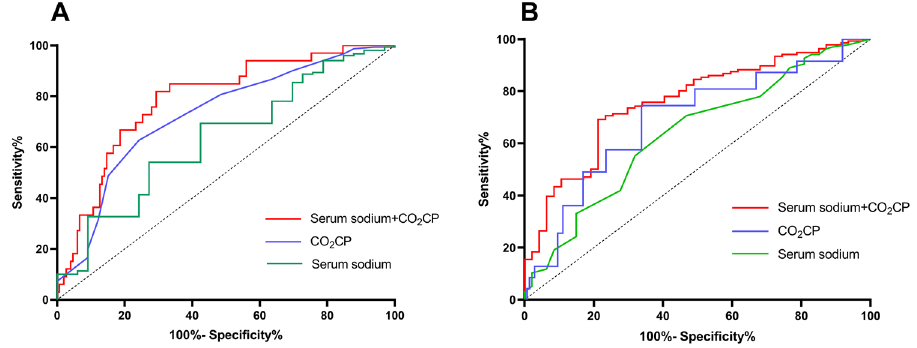
Figure 1. ROC curves comparing CO 2 CP, serum sodium and its combination for prediction. ( A ) All-cause death; ( B ) adverse events.